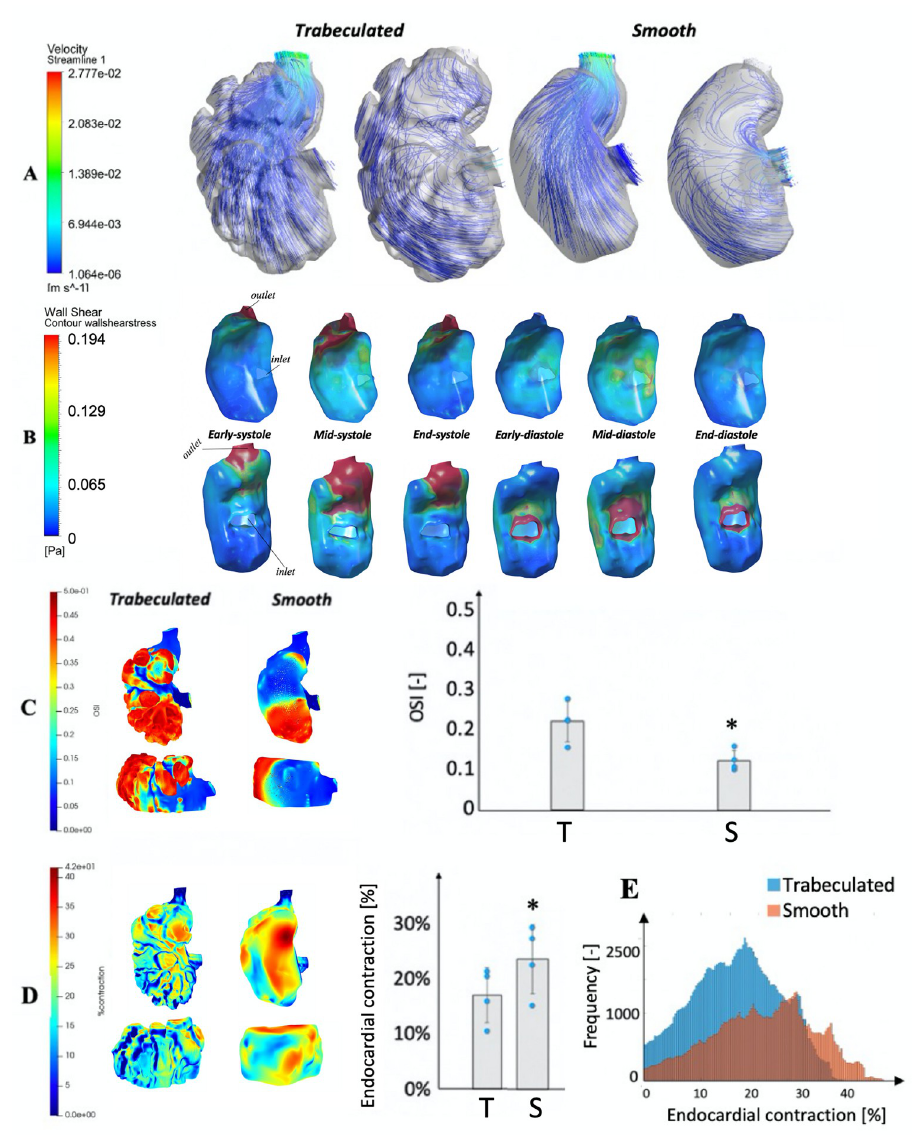
Fig 6. Comparison of hemodynamic parameters between traeculated and smooth embryonic ventricles. (A) Velocity streamlines for both trabeculated and smoothed wall simulations of a 3dpf zebrafish embryonic heart from lateral views, at (left) the end-diastolic phase and (right) the mid-systolic phase. (B) Contour maps of endocardial WSS in the same embryonic ventricle of Fig 2, but with a totally smooth geometry, over the cardiac cycle with the assumption that fluid has the viscosity of plasma (1.5cP). Top row: ventral view of the outer curvature of the ventricle; bottom row: dorsal view of the inner curvature (C) Spatial pattern and surface-averaged magnitudes of oscillatory shear index (OSI) for both trabeculated (T) and smoothed (S) wall simulations of a 3dpf zebrafish embryonic heart, from lateral and ventral views. (D) Spatial pattern and surface averaged-magnitudes of endocardial contractile surface area strains (end-diastole to end-systole), for both the trabeculated (T) and smoothed (S) simulations, from the same views. (E) Histograms of the endocardial contraction across surface locations for the trabeculated and smooth models of the same ventricular chamber. � p values were found to be at the minimum possible with the small sample size ( n = 4, p =